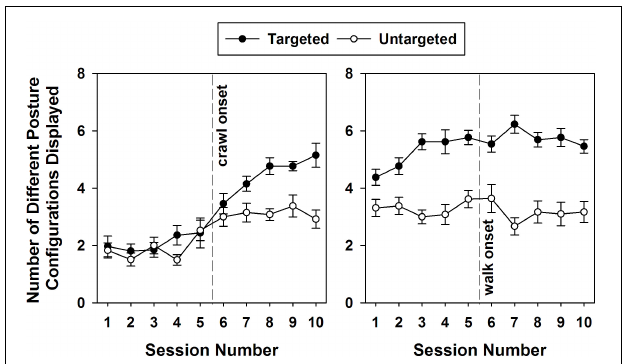
FIGURE 2 | Mean numbers and standard errors of posture configurations displayed by infants over the 10 sessions surrounding the crawling (left) and walking (right) transitions as function of targeted